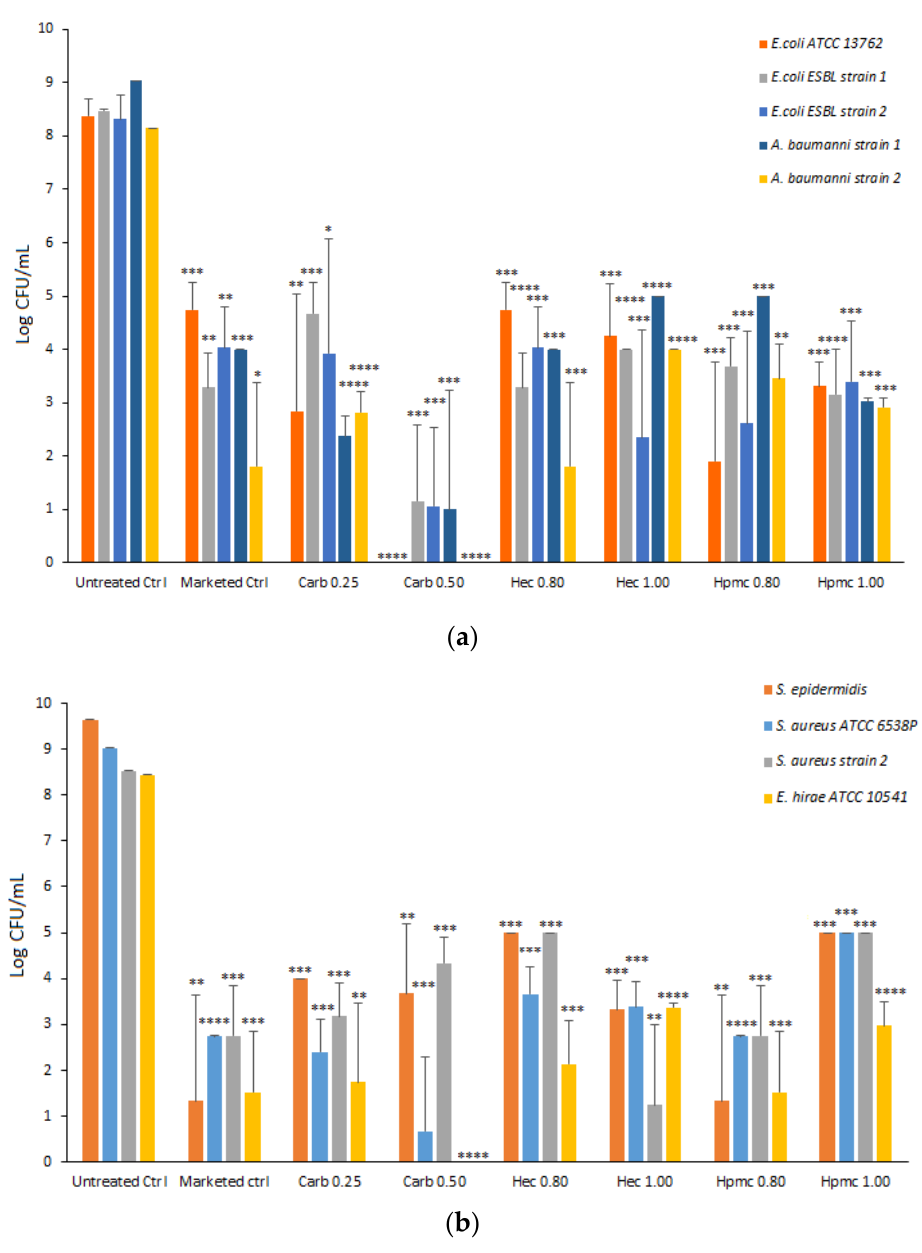
Figure 8. In vitro antimicrobial activity of alcohol-based gels against Gram-negative bacteria ( a ) and Gram-positive bacteria ( b ) (* p < 0.05, ** p < 0.01, *** p < 0.001 and **** p < 0.0001).